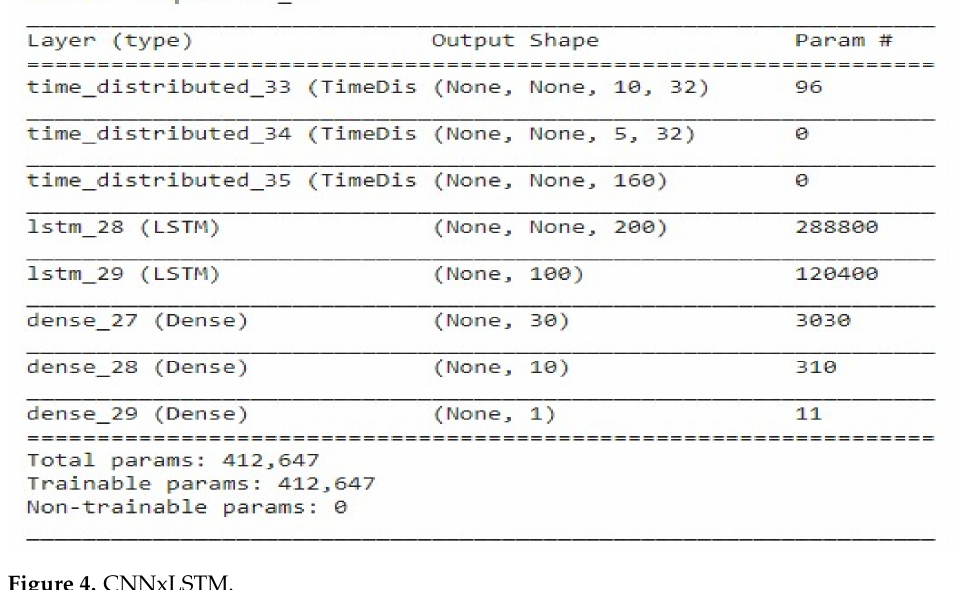
Figure 4. CNNxLSTM.